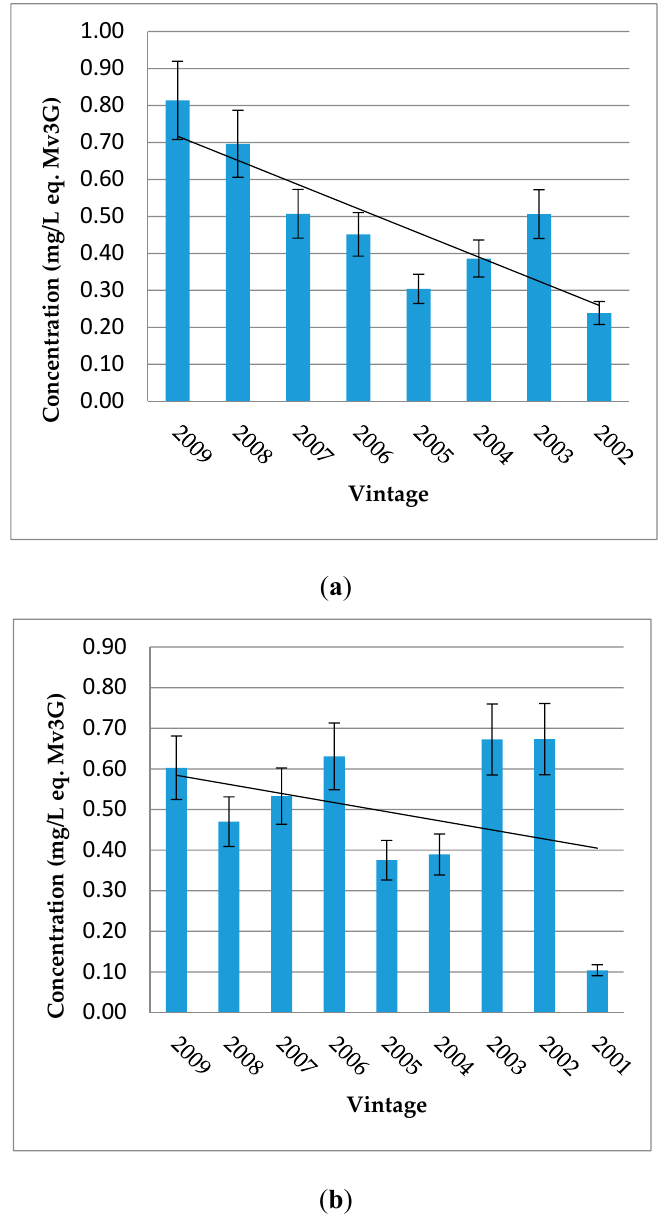
Figure 2. Distribution of vitisin A by vintage for each wine-growing region: Aquitaine ( a ) and Rioja ( b ). Error bars are standard deviation of wine samples within each category.